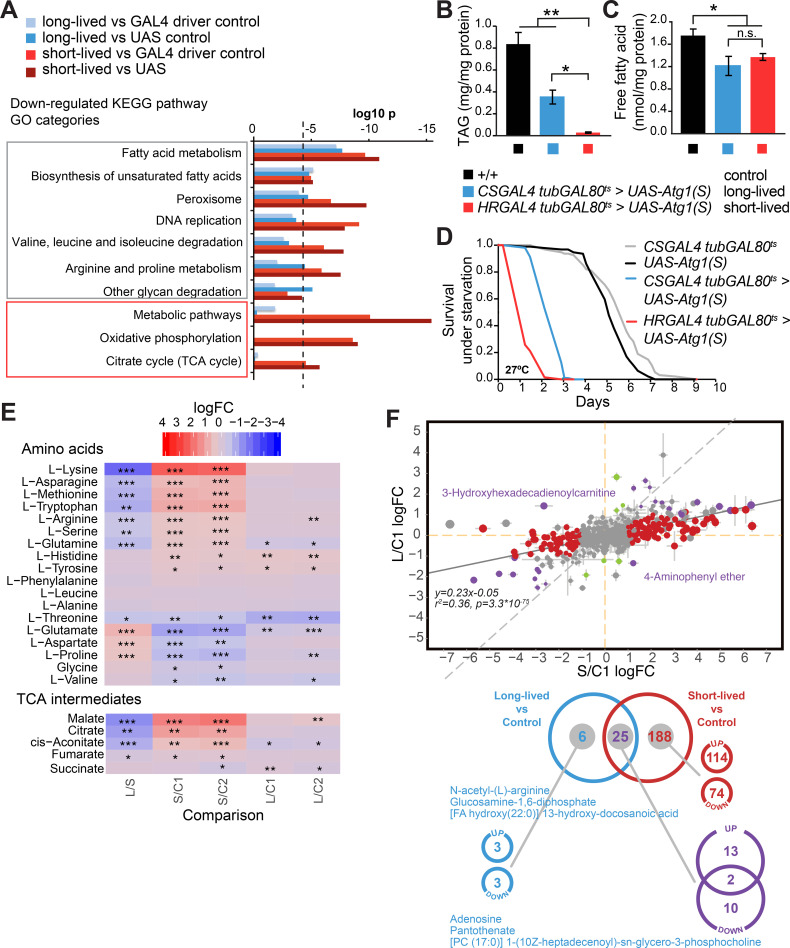
Transcriptomic analysis of the long-lived and short-lived Atg1 over-expressing flies reveals decreased lipid metabolism.(A) The KEGG pathway GO categories that were primarily down-regulated upon autophagy induction were related to lipid metabolism. The trend of transcriptional changes was similar in both the long-lived and short-lived Atg1 over-expressing flies. The categories down-regulated only in the short-lived Atg1 over-expressing flies were metabolic pathways, oxidative phosphorylation, and citrate cycle (TCA cycle). (B) Reduced TAG levels in the autophagy enhanced flies compared to controls. Data are means ±SEM of n = 8 replicates. Statistical significance was calculated by one-way ANOVA Student’s t-test (*, p<0.05; **, p<0.01). (C) Reduced free fatty acid levels in both Atg1 over-expressing flies compared to controls. Data are means ±SEM of n = 5 replicates. Statistical significance was calculated by Student’s t-test (*, p<0.05). (D) Flies with up-regulated autophagy were significantly more sensitive to starvation stress (p<0.001, log rank test compared to controls). (E) Side-by-side comparison of changes for amino acid and TCA cycle intermediates in Atg1 over-expressing flies. Two controls are used for normalisation: C1 = driver control CSGAL4 tubGAL80ts, and C2 = UAS-Atg1(S). Major differences between the long-lived (L) and short-lived (S) flies are represented. Colours show logFC, stars indicate significance: FDR<0.05 = *, FDR<0.01 = **, FDR<0.001 = ***. (F) Comparison of metabolic changes in Atg1 over-expressing flies. Scatterplot visualising the correlation of changes in short-lived and long-lived flies. For illustrative purposes, only the comparison against C1 is shown. Linear regression is provided in the Fig. Two annotated metabolites in the scatterplot change in opposite directions in the Atg1 over-expressing flies. Venn diagram illustrating metabolite changes in Atg1 over-expressing flies that are consistent in comparison to both controls, C1 = CSGAL4 tubGAL80ts, and C2 = UAS-Atg1 (S). Only metabolites with a logFC amplitude >1 and significance of FDR<0.05 are considered. The Venn diagram is further broken down according to the direction of change in a selected subset of data with some of the metabolites highlighted.